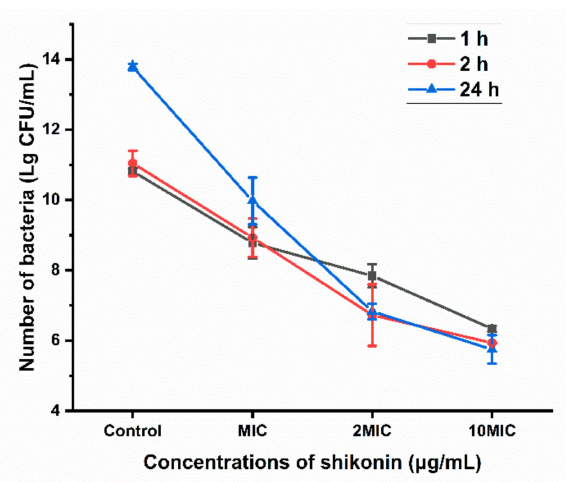
Figure 7. Shikonin inhibited the growth of S. aureus in the